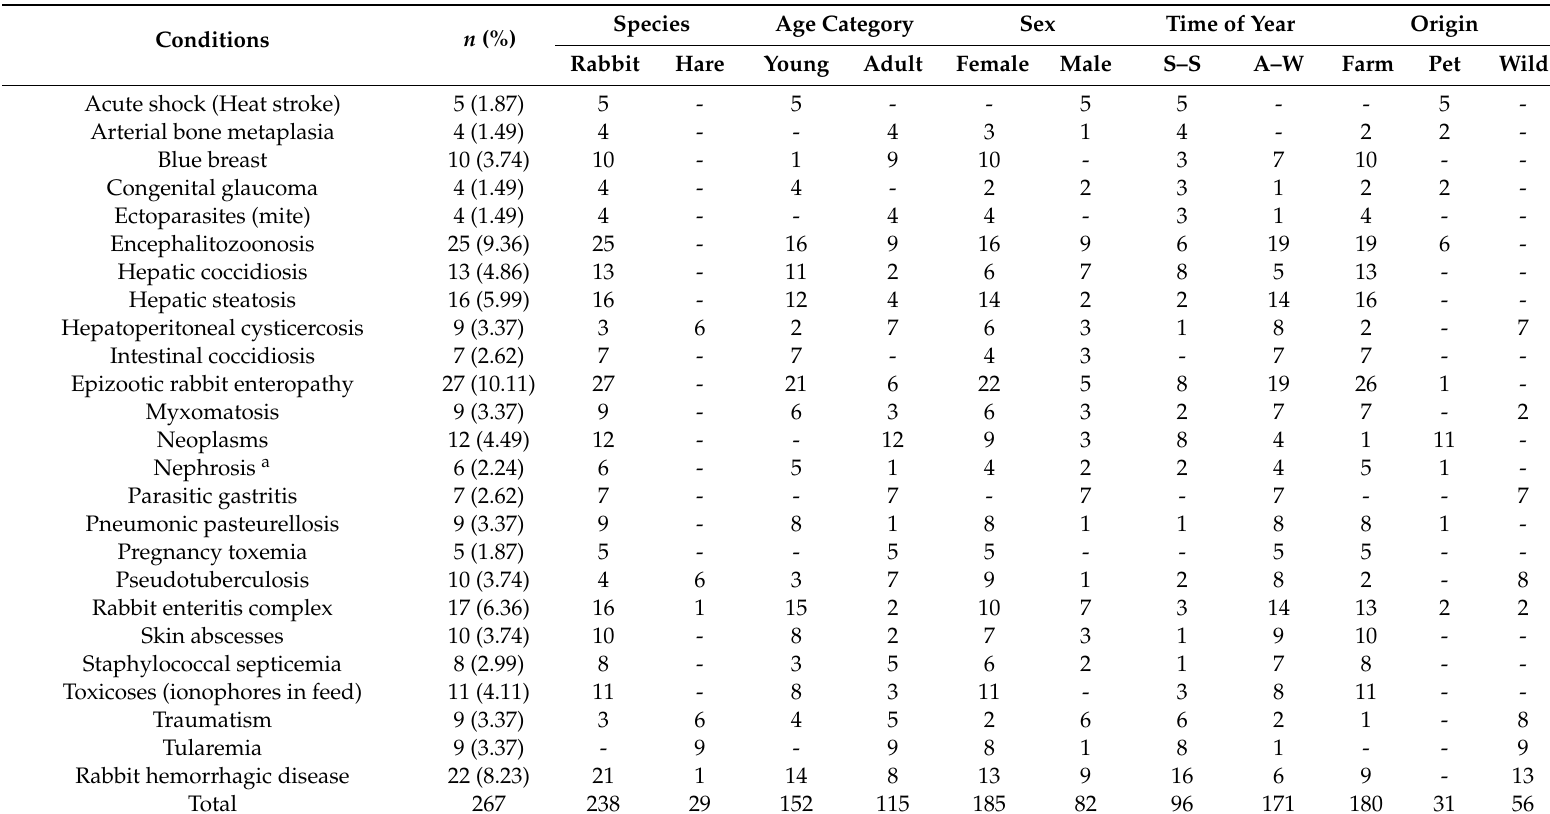
Table 2. Summary of diseases or conditions diagnosed as a single cause of death or illness in lagomorphs referred to Department of Animal Health (Faculty of Veterinary Science, University of Le ó n, Spain) during